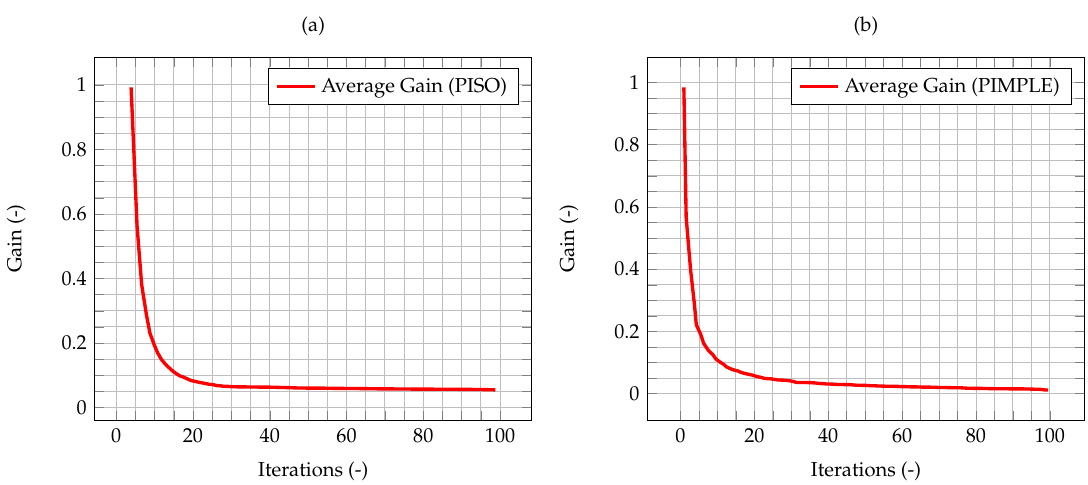
Figure 8. Time evolution of the average Kalman gain for the PISO algorithm with fixed time step equal to 0.005 s ( a ) and the PIMPLE algorithm ( b ) with time adaptivity and initial time step equal to 0.005